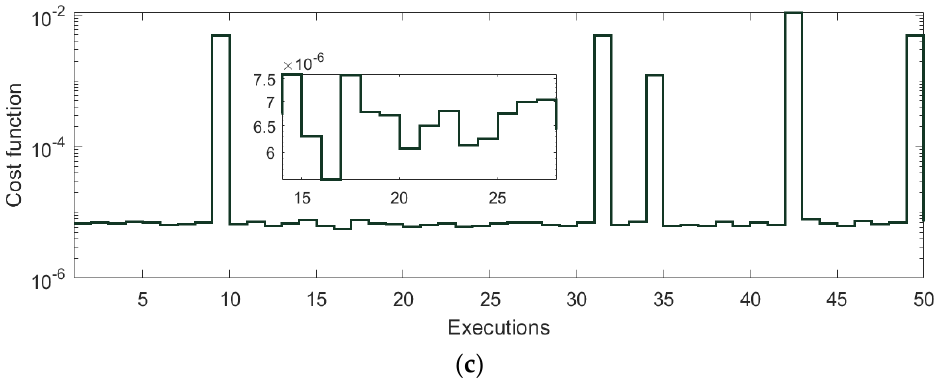
Figure 10. Monte Carlo simulation results for 0.5 λ ( a ) 200 dB ( b ) 70 dB ( c ) 50 dB.